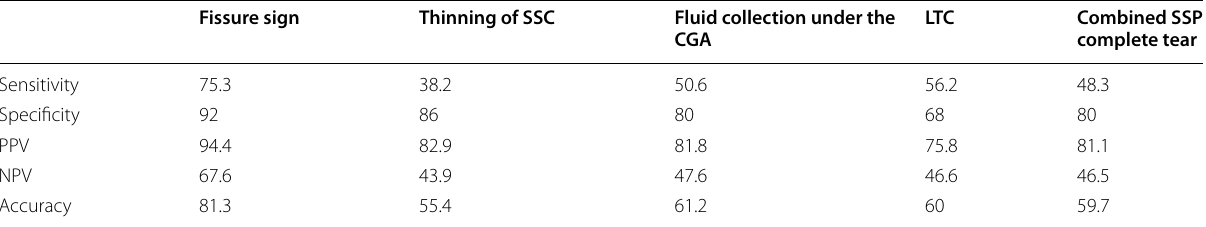
Table 4 Diagnostic performance of the associated imaging signs on MRI interpretations compared to arthroscopic findings (gold standard)